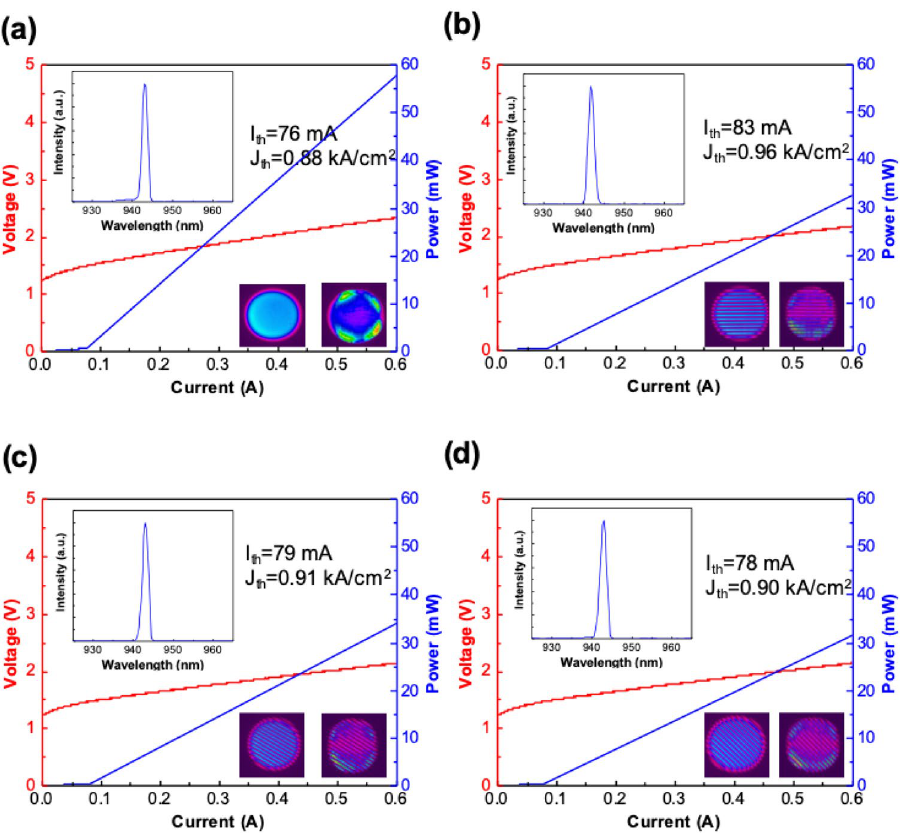
Figure 3. The L–I–V curve, threshold current, threshold current density, lasing wavelength and Near-field emission patterns (below and above threshold) of ( a ) PCSEL without grating structure, ( b ) VIDG-PCSEL with 0° grating, ( c ) VIDG-PCSEL with 30° grating and ( d ) VIDG-PCSEL with 45° grating,